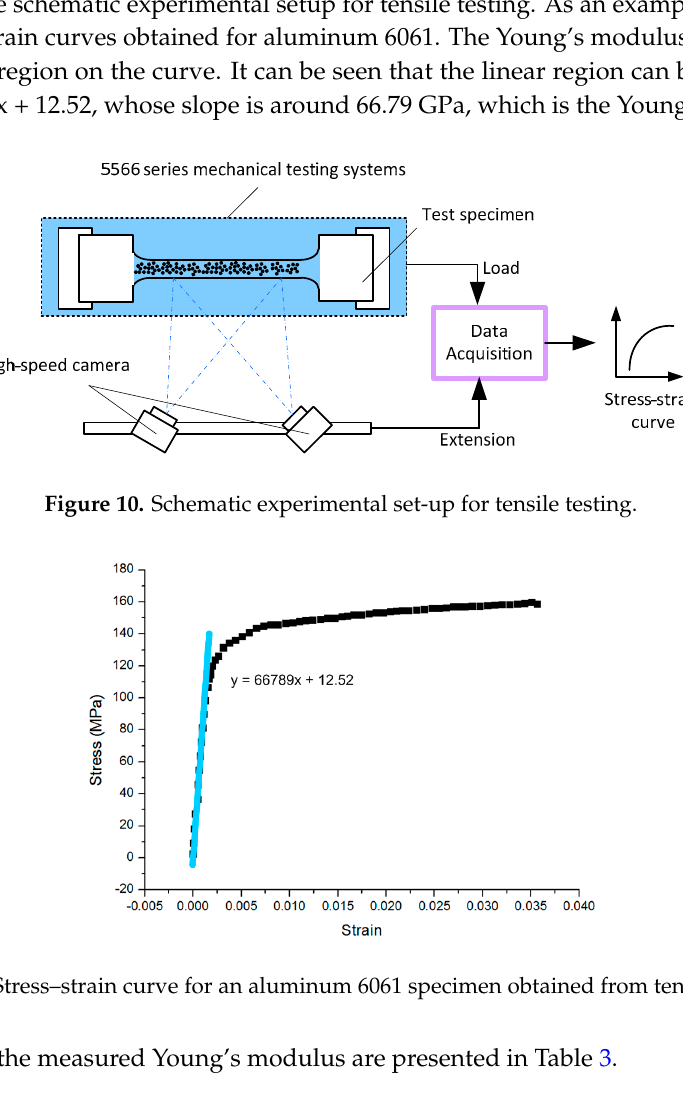
Figure 11. Stress–strain curve for an aluminum 6061 specimen obtained from tensile testing.